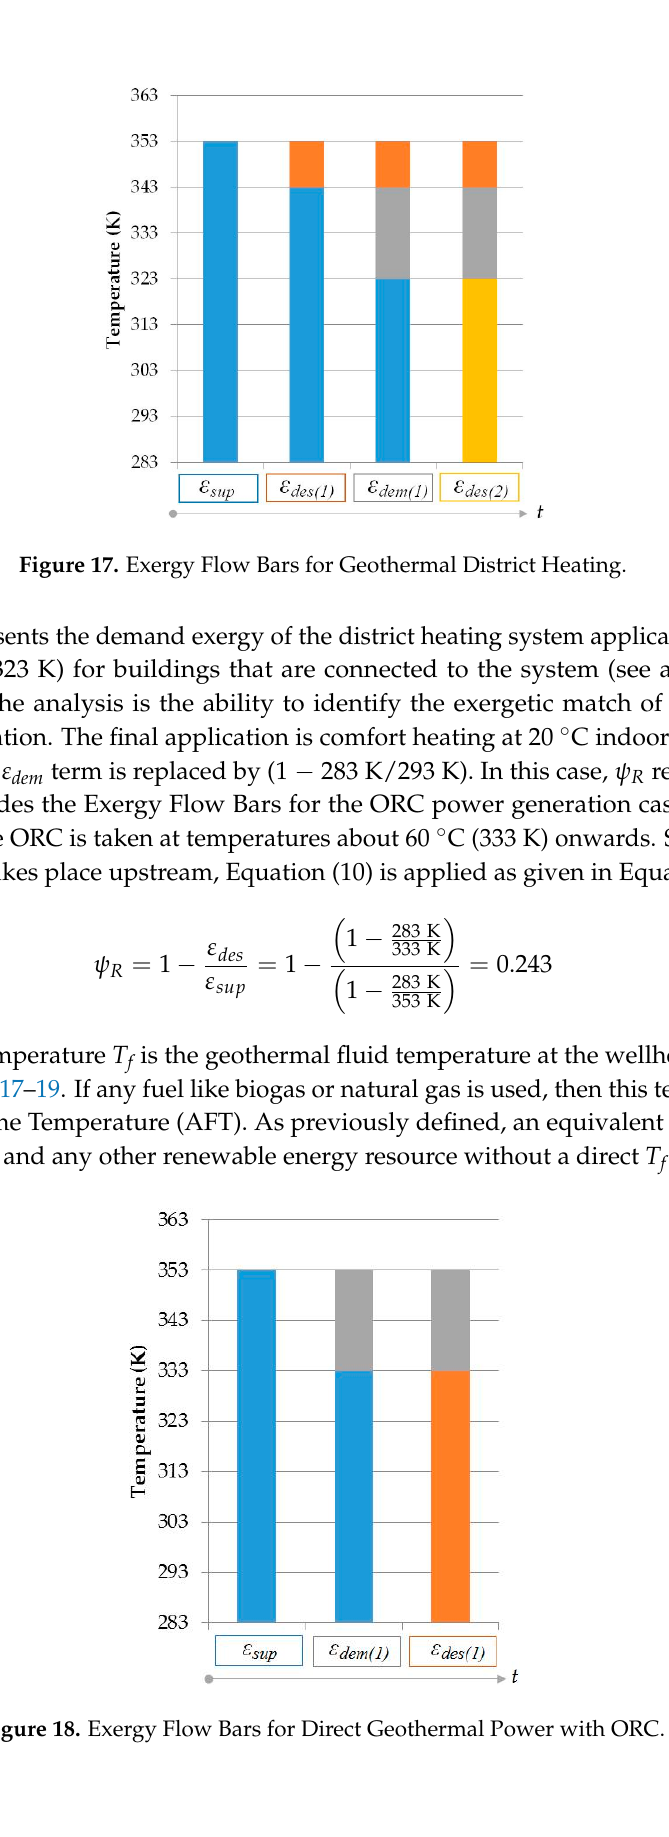
Figure 18. Exergy Flow Bars for Direct Geothermal Power with ORC.